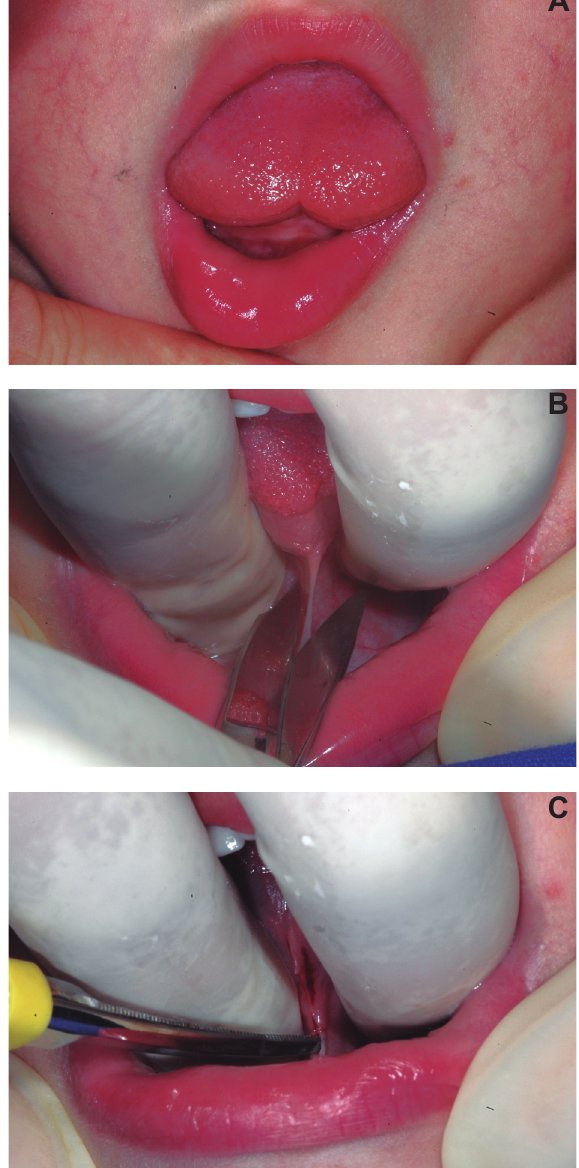
Figure 1- Frenotomy in a baby with ankyloglossia. A) Heart-shaped tongue during protrusion caused by a short lingual frenulum with anterior insertion. B) Tongue being held up towards the palate and scissors in position to cut the frenulum. C) Frenulum was cut through the white, fascia-like tissue along a line parallel with the